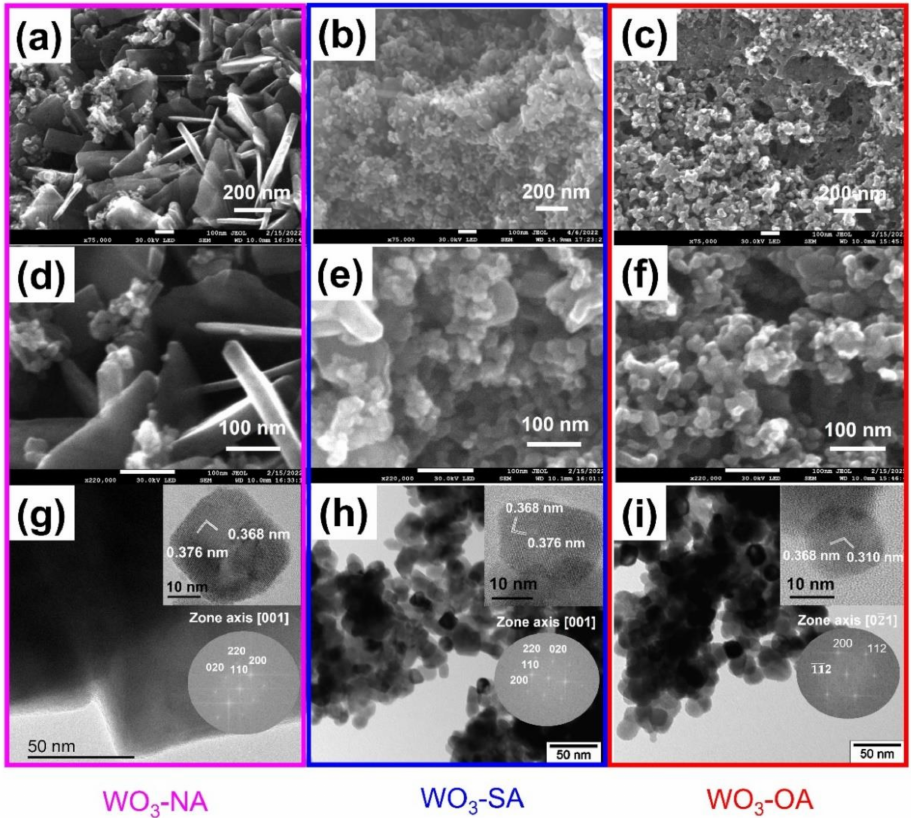
Figure 1. SEM ( a – f ), TEM ( g – i ), and corresponding HRTEM and FFT images (inset) of the products of tungsten electrochemical oxidation under pulse alternating current in nitric ( a , d , g ), sulfuric ( b , e , h ), and oxalic ( c , f , i )